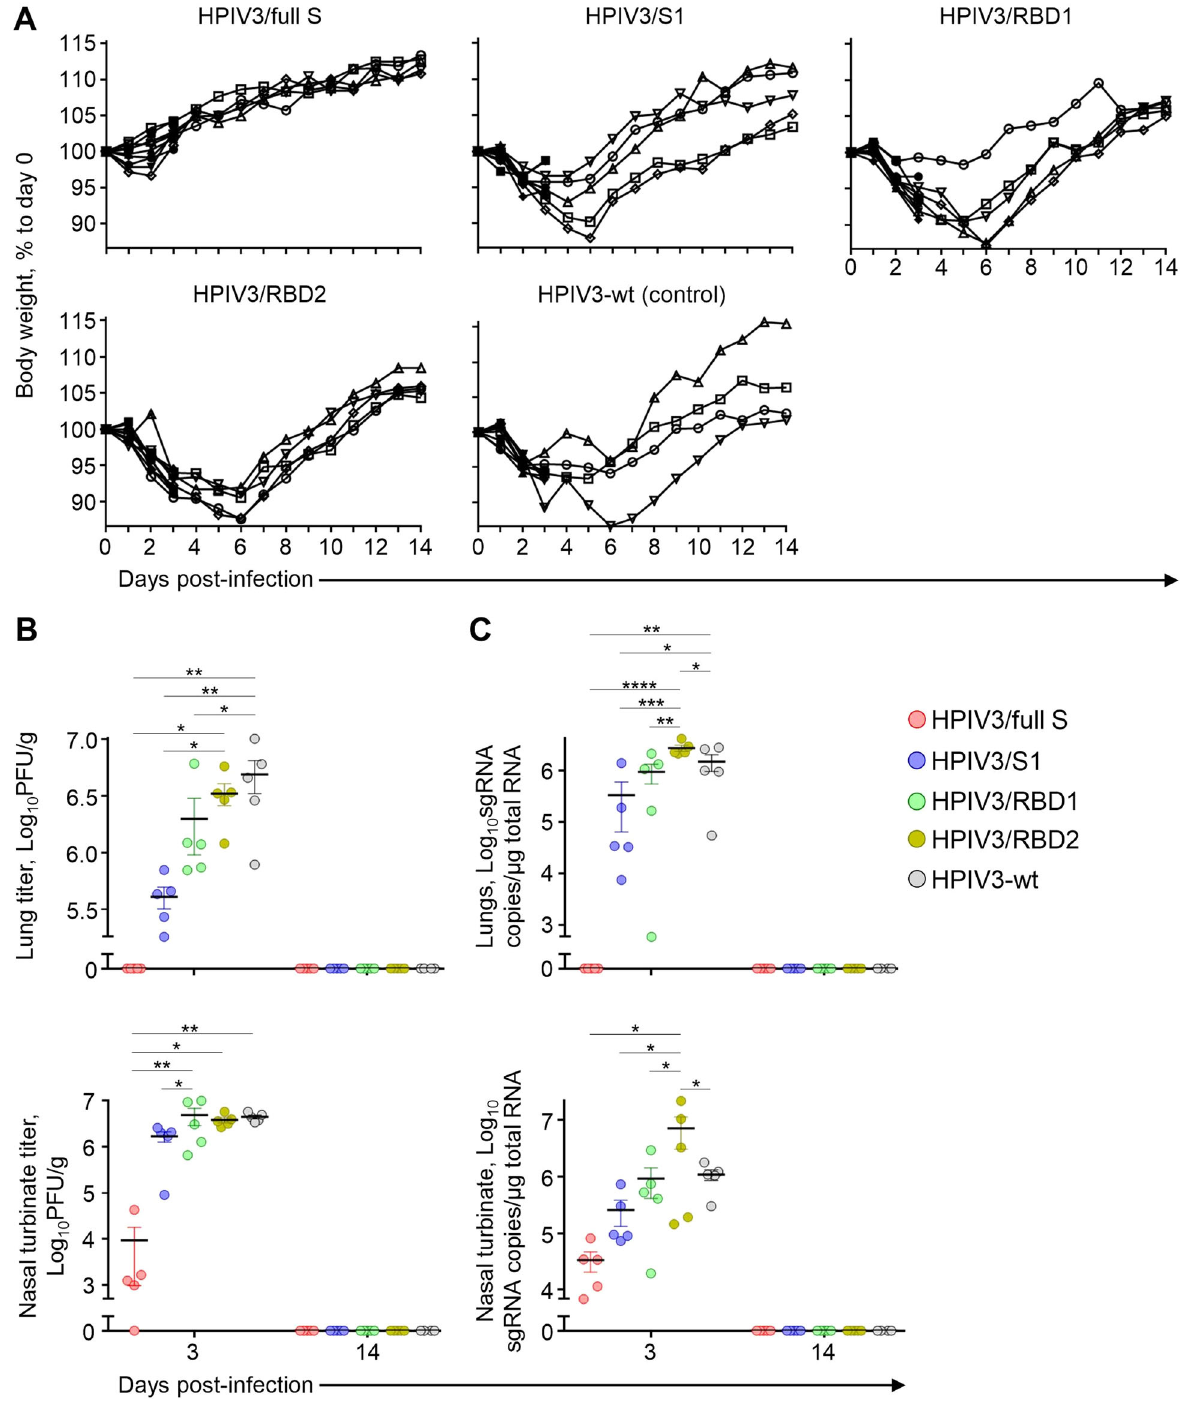
Fig. 5 HPIV3 vaccine expressing full S protein protects hamsters against SARS-CoV-2 infection. Groups of hamsters at 10 animals per group were immunized with the indicated vaccine constructs by the intranasal route and challenged with SARS-CoV-2 in 28 days after immunization. Body weight curves are shown ( A ). On days 3 or 14 post-infection, animals were euthanized to determine viremia ( B) and viral load ( C ) in lungs and nasal turbinates. B , C each dot corresponds to individual sample. Data represent mean ± SEM of n = 4 – 5 per group. * p < 0.05; ** p < 0.01; *** p < 0.001; **** p < 0.0001 (one-way ANOVA with multiple comparisons, Fisher ’ s LSD SARS-CoV-2 S protein (Ad5-S-nb2) was able to elicit neutralizing Despite good ef fi cacy of multiple IM vaccines against SARS-CoV- antibody response in the bronchoalveolar lavage fl uid 47 . In the 2, a direct mucosal delivery may be necessary to attain robust protective immunity in the lungs. In BALB/c mice, only an IN study with an integrase-de fi cient, non-integrative version of inoculation, but not an IM injection, of a replication-incompetent lentivirus expressing the full-length S protein administered as IM recombinant adenovirus serotype 5 that carries the full-length prime/IN boost vaccine, the boost immunization signi fi cantly